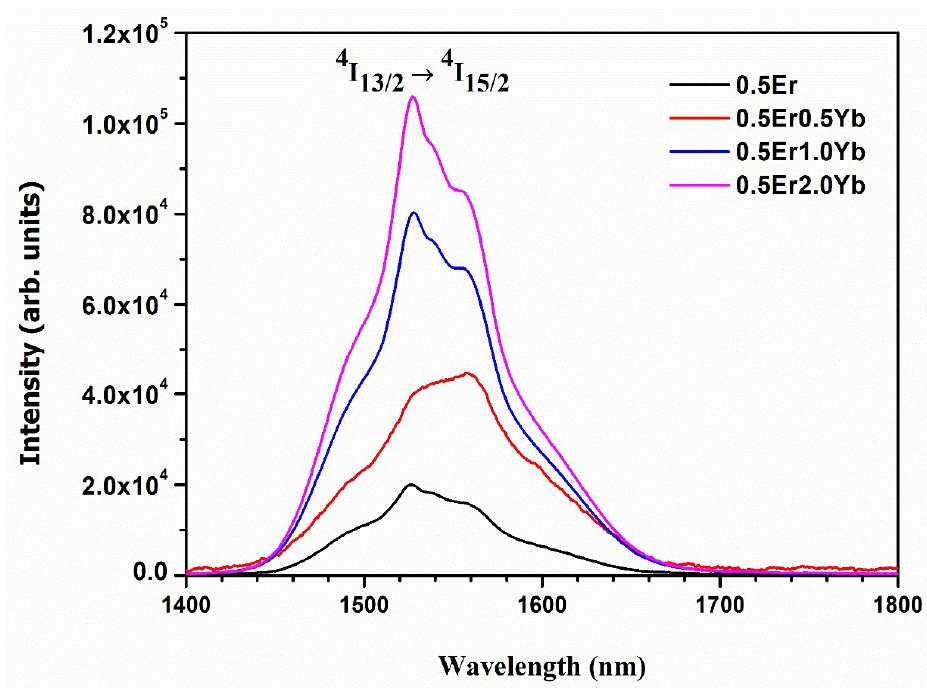
Figure 6. Near-infrared emission 0.5 mol% Er 3+ ions and Yb 3+ ions co-doped ZBB glasses. Figure 6. Near ‒ infrared emission 0.5 mol% Er 3+ ions and Yb 3+ ions co ‒ doped ZBB glasses.